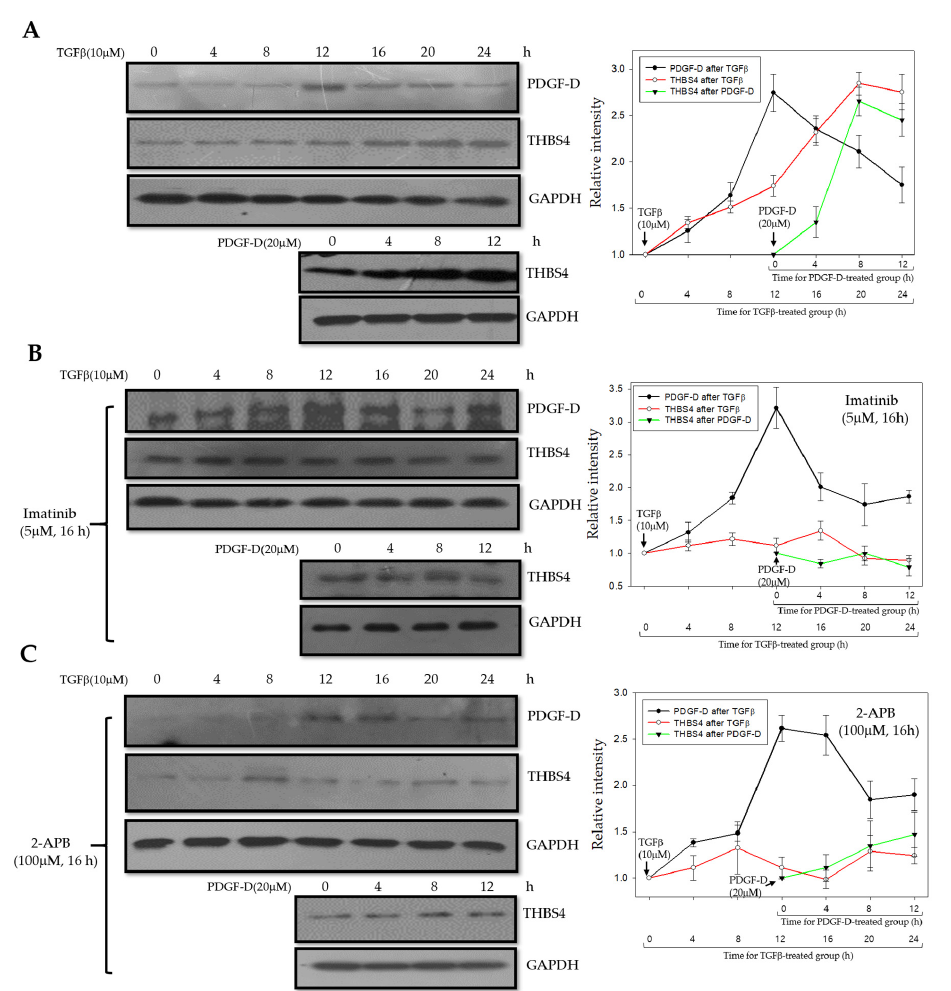
Figure 5 . Effect of imatinib and 2-APB on THBS4 regulation by TGF β and PDGF-D in a time-dependent manner. ( A ) Western blot with anti-PDGF-D and anti-THBS4 antibodies in the presence of TGF β 10 µM (0, 4, 8, 12, 16, 20, and 24 h) or with anti-THBS4 antibody in the presence of PDGF-D 20 µM (0, 4, 8 and 12 h) in DLD-1 cells. ( B ) Western blot with anti-PDGF-D and anti-THBS4 antibodies in the presence of TGF β 10 µ M (0, 4, 8, 12, 16, 20, and 24 h) or with anti-THBS4 antibody in the presence of PDGF-D 20 µM (0, 4, 8, and 12 h) in DLD-1 cells cultured with imatinib 5 µM for 16 h. ( C ) Western blot with anti-PDGF-D and anti-THBS4 antibodies in the presence of TGF β 10 µ M (0, 4, 8, 12, 16, 20, and 24 h) or with anti-THBS4 antibody in the presence of PDGF-D 20 µ M (0, 4, 8 and 12 h) in DLD-1 cells cultured with 2-APB 100 µ M for 16 h. The graphs in the right panel represent the relative expression of PDGF-D (black line with closed circle). THBS4 (red line with open circle) in relation to exposure (time, h) with TGF β and the relative expression of THBS4 after the addition of PDGF-D (green line with closed triangle) through 12 h. Three independent experiments were performed in